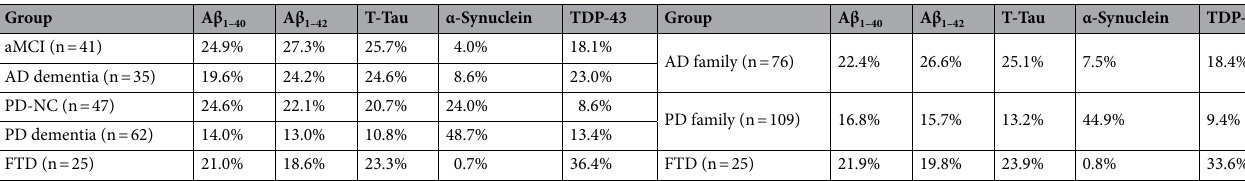
Table 4. Dominance of plasma Aβ 1–40 , Aβ 1–42 , T-Tau, α-synuclein and TDP-43 in aMCI, ADD, PD-NC, PDD and FTD. aMCI amnesic mild cognitive impairment, AD Alzheimer’s disease, PD Parkinson’s disease, PD-NC Parkinson’s disease with normal cognition, FTD frontotemporal